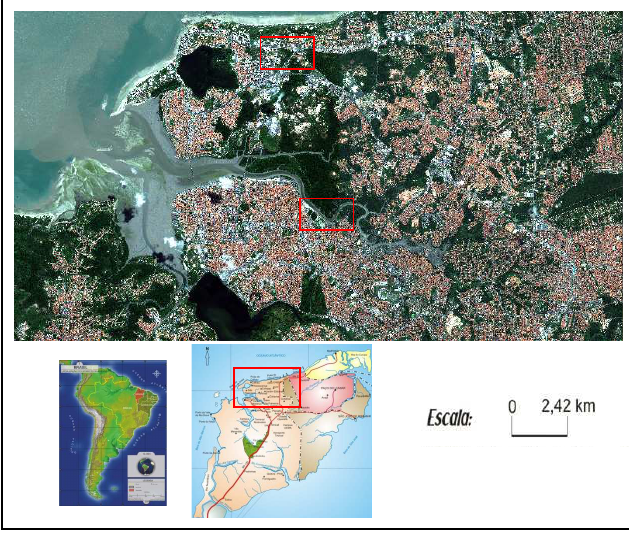
Figure 1 – Localization of test sites Source: Adapted from WorldView-2 image dated July 10th 2010. (DIGITALGLOBE,